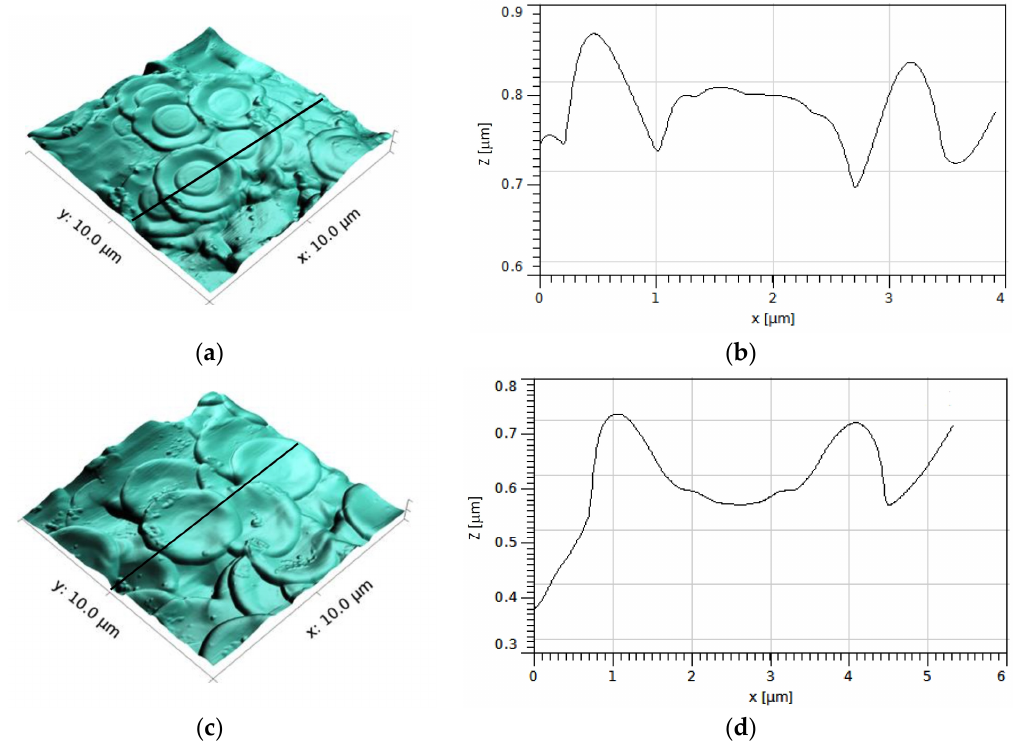
Figure 4. Atomic force microscopy (AFM) images and the relief profiles obtained for the coatings on the working surface of RS blades after the commutation test with I c = 0.4 A and 10 6 switching cycles: ( a , b ) cathode; ( c , d ) anode. The relief profiles were measured along the lateral trace lines shown in panels (a,c). Table 1. Geometrical characteristics of the cathode features versus the commutation current.